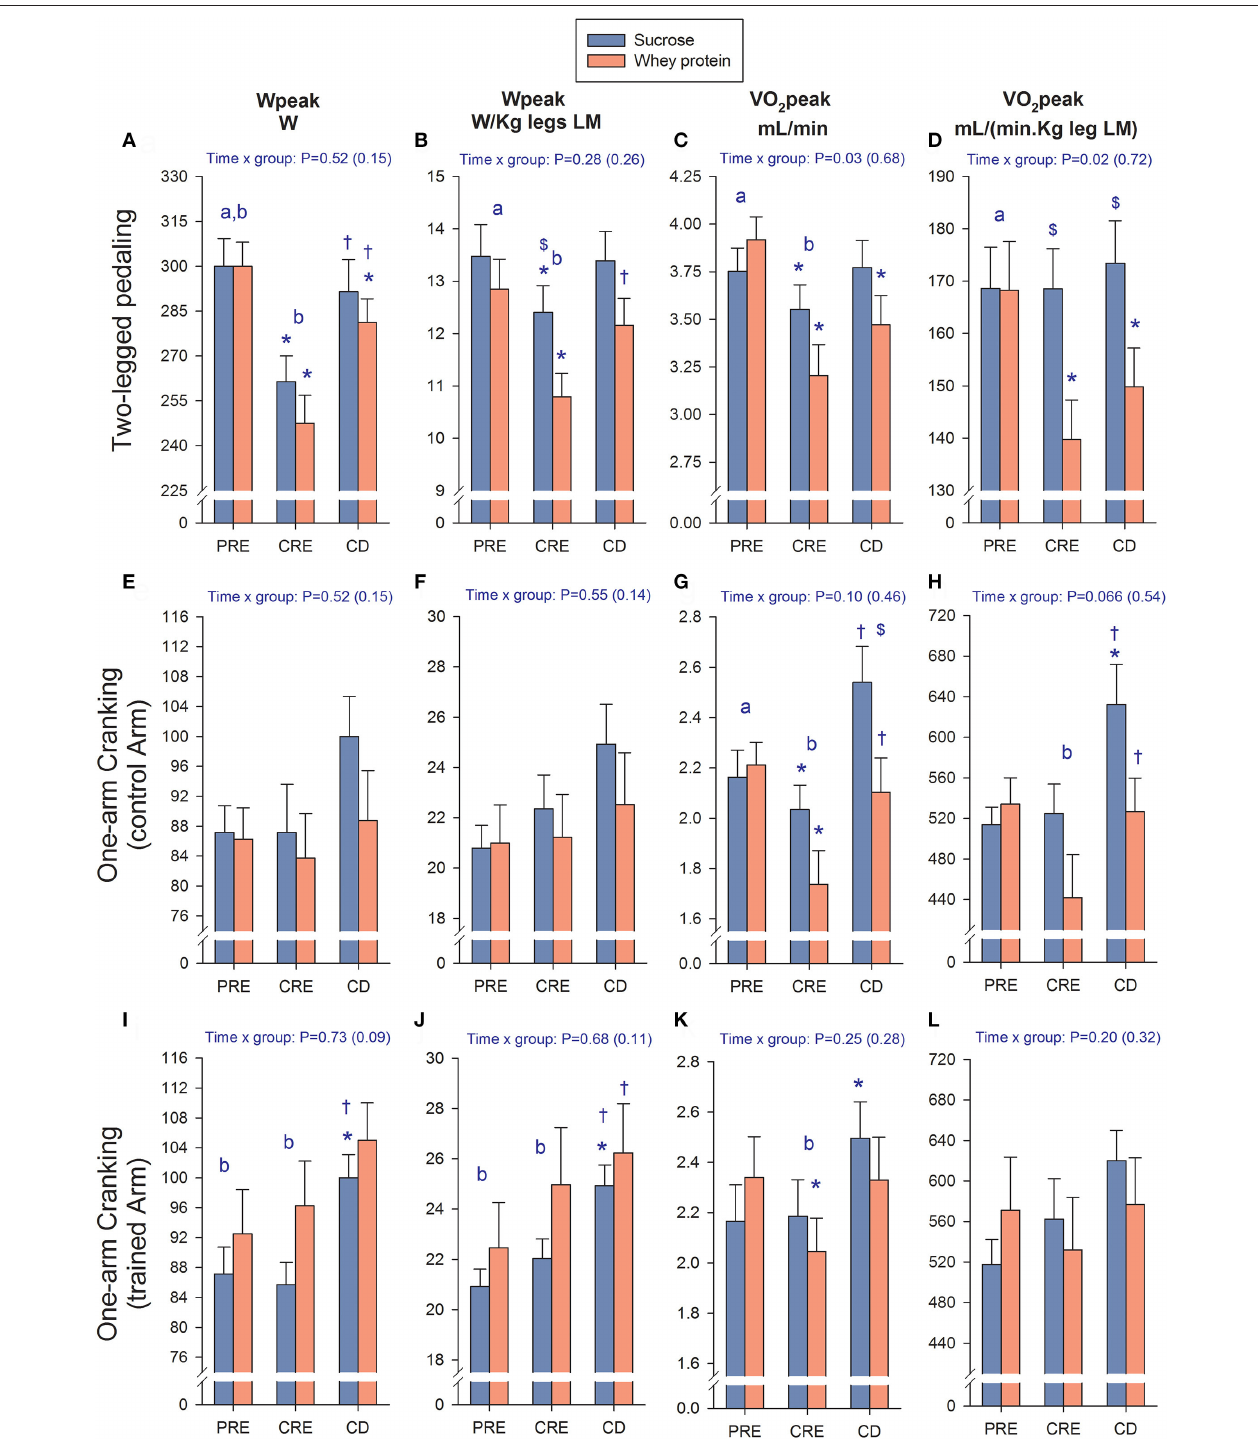
FIGURE 3 | Changes in performance. Assessment of changes in peak power output (Wpeak) and peak oxygen uptake (VO 2 peak) in absolute and relative values (LM, lean mass) during two-legged pedaling (A–D) , one-arm cranking with the control arm (E–H) , and one-arm cranking with the trained arm (I–L) . PRE, baseline tests; CRE, caloric restriction (13.4 kJ/day) and exercise (45 min arm cranking and 8h walking per day) for 4 days; CD, 3 days on a diet isoenergetic with that consumed during the PRE phase + reduced exercise. The vertical bars represent the mean values and the error bars the standard error of the mean. Sucrose ( n = 7) and whey protein group ( n = 8). * P < 0.05 compared to PRE; † P < 0.05 compared to CRE; $ P < 0.05 sucrose compared to whey protein; a P < 0.05 compared to CRE (time main effect); b P < 0.05 compared to CD (time main effect).